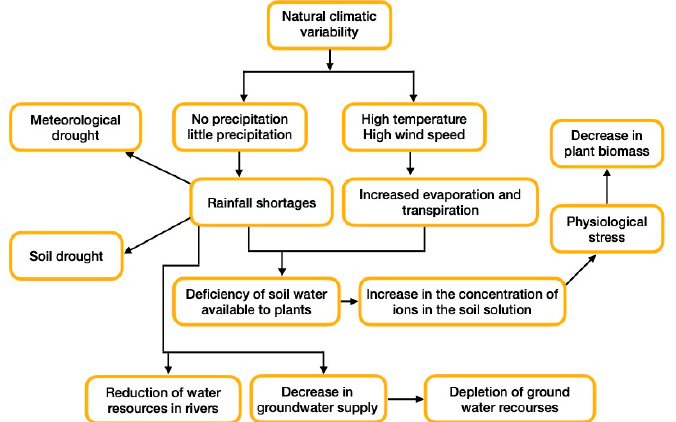
Figure 1. A brief graphic overview depicting the different phases of the hydrological cycle leading to drought, which generates a significant stress response in